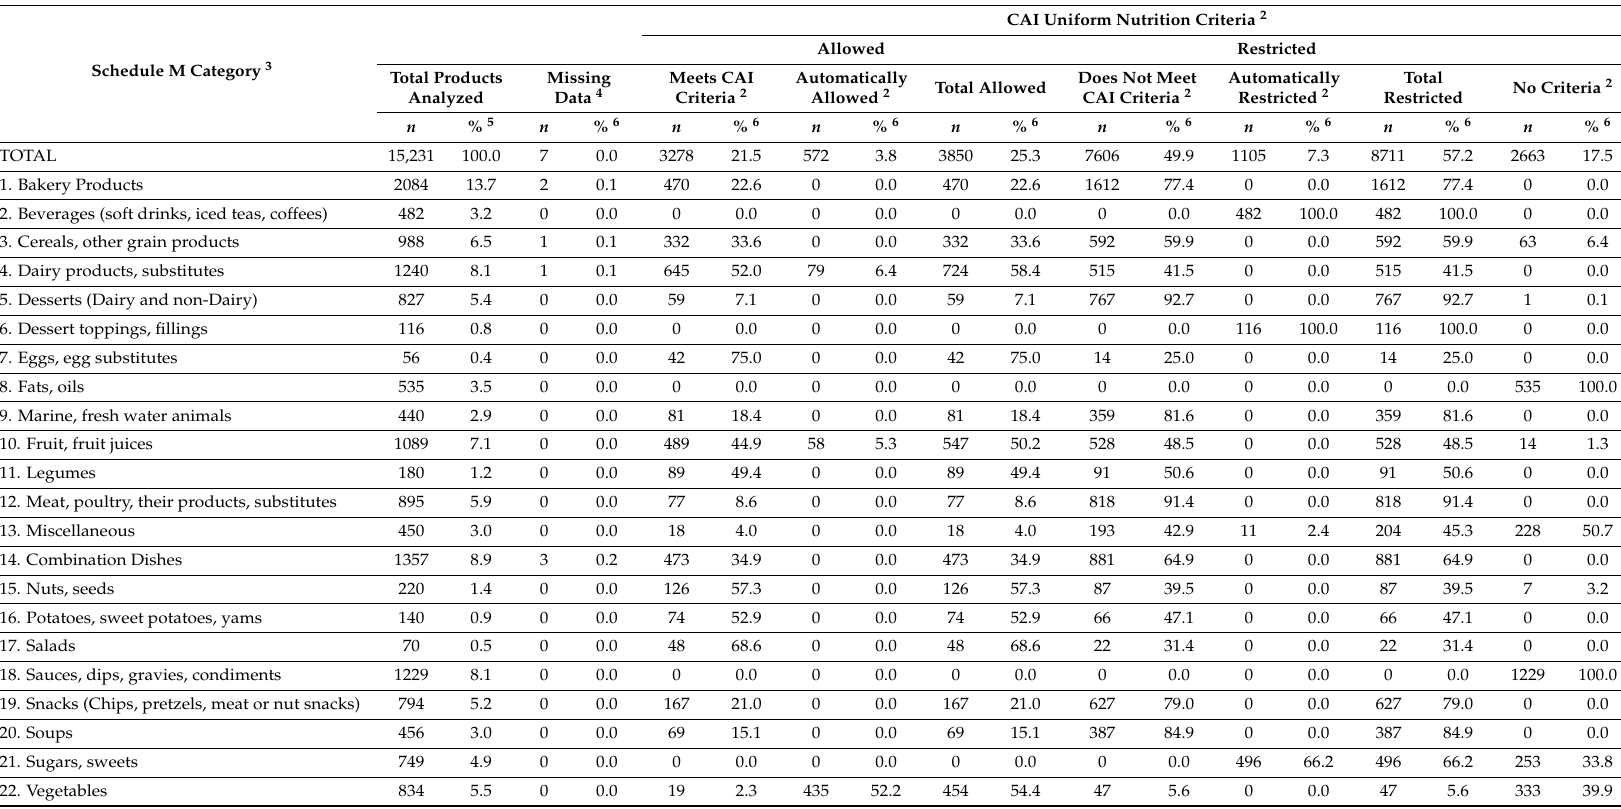
Table 1. Evaluation of Canadian packaged food and beverage products 1 according to the Canadian Children’s Food and Beverage Advertising Initiative’s (CAI) Uniform Nutrition Criteria 2 , presented overall and by major food category 3